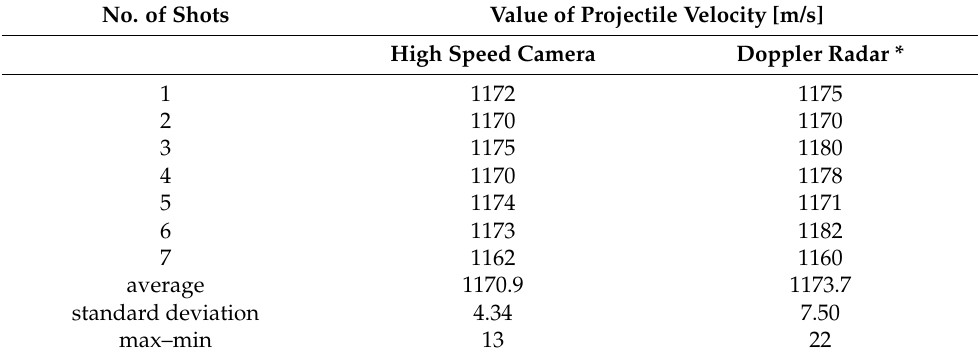
Table 3. Results of velocity measurements.